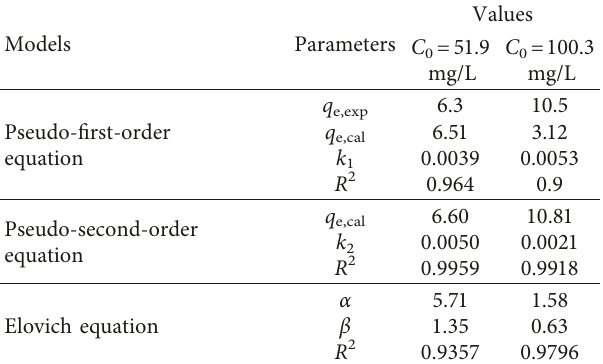
Table 2: Parameters of the three kinetic equations for RR-2 ad- sorption on MOSP-MMT.